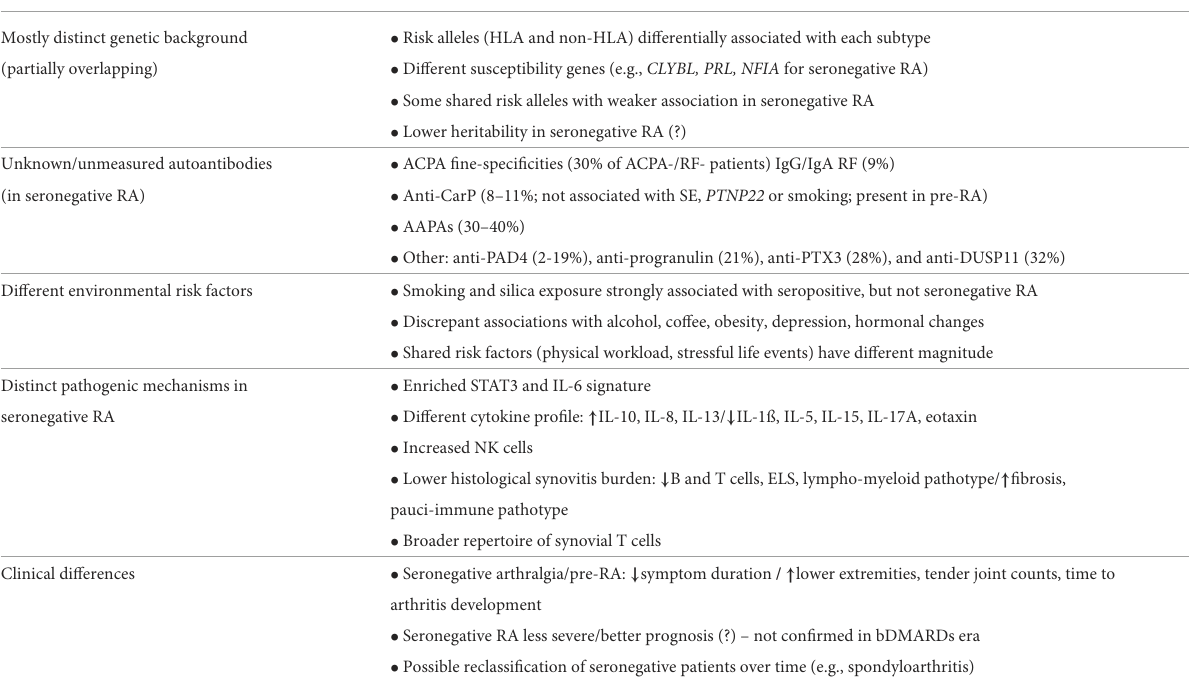
TABLE 2 Essential aspects differentiating seropositive and seronegative